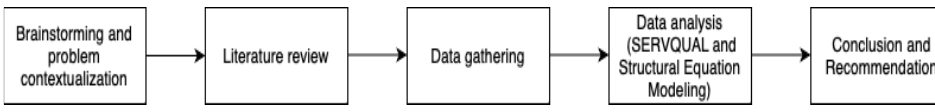
Figure 3. Methodology. Figure 3.